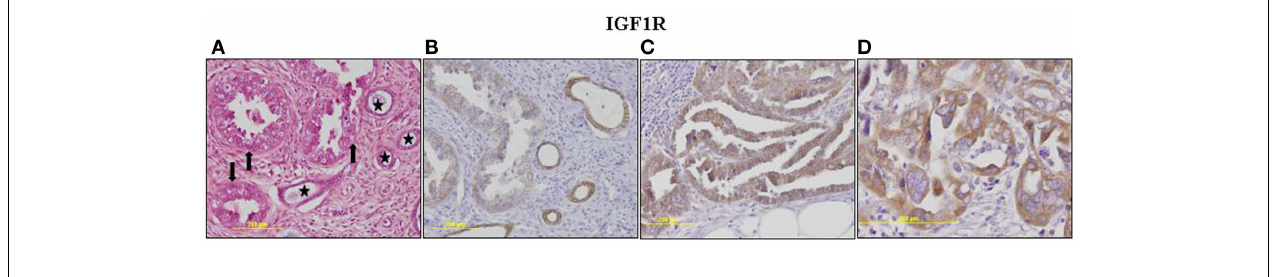
cells in adjacent non-neoplastic glands. (C) Metastasis , moderate cytoplasmic staining in nearly all neoplastic cells. (D) Metastasis , a focus of increased atypia. Moderate and strong staining in all neoplastic cells. Some of the immunohistochemical figures were shown in Ref.